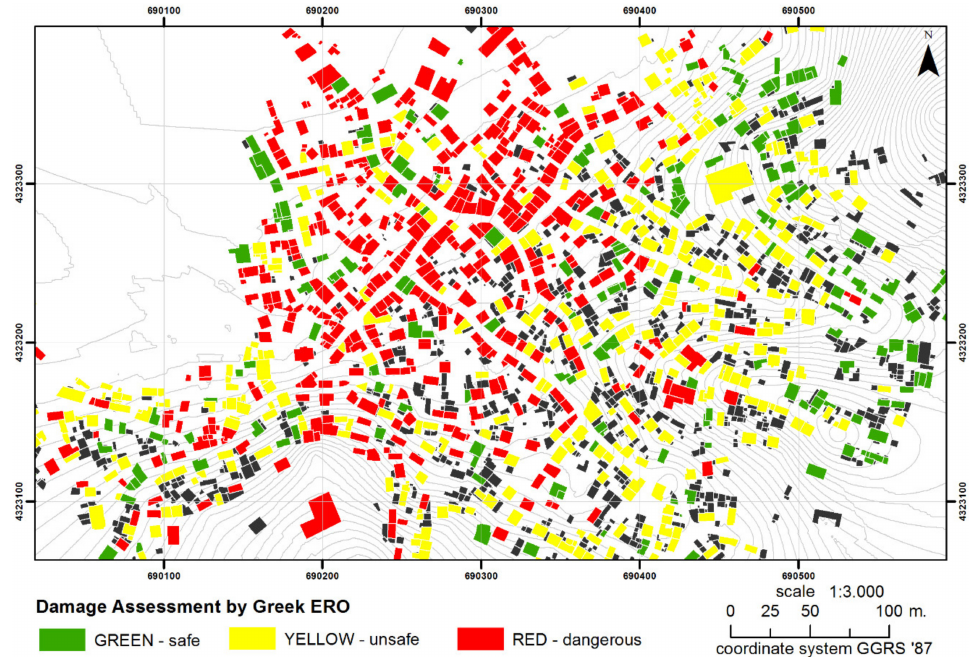
Figure 2. Damage assessment of Vrisa building stock after the final inspection by Greek ERO (black buildings present uninspected